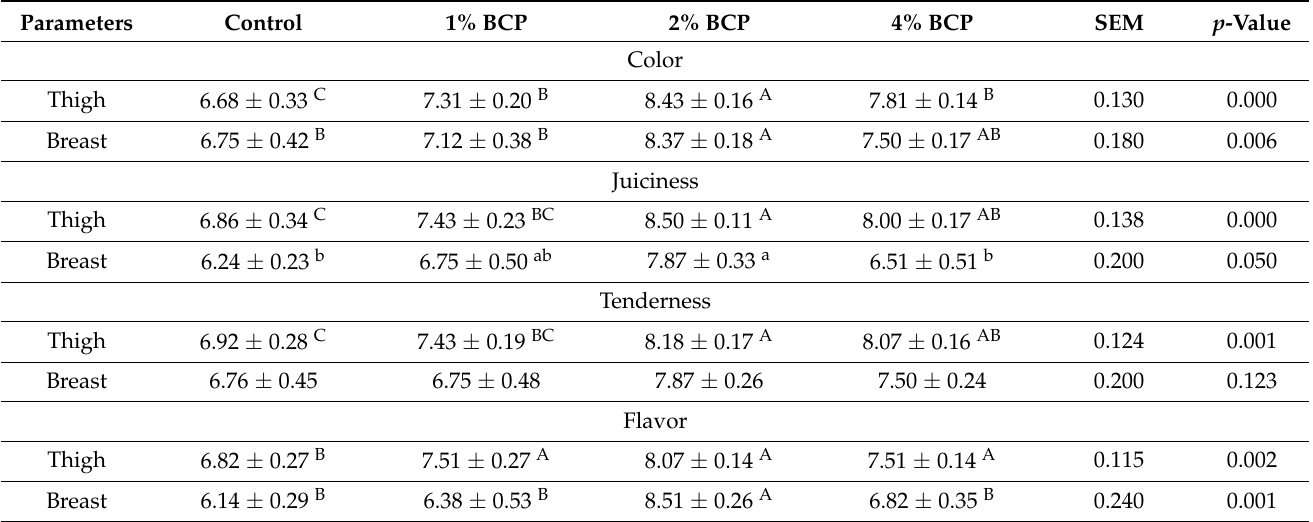
Table 8. The sensory characteristics of the cooked meat of the Japanese quail as influenced by dietary